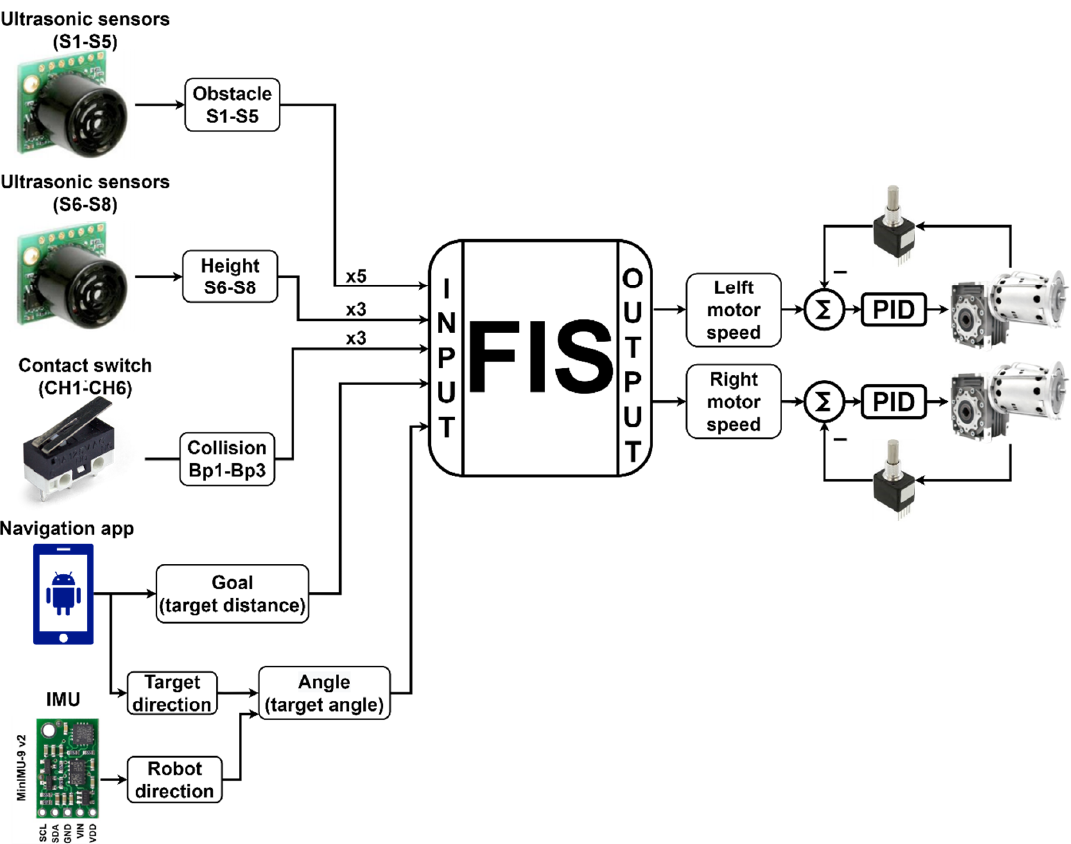
Figure 13. Real model fuzzy inference system (FIS) macro diagram with PID control application.